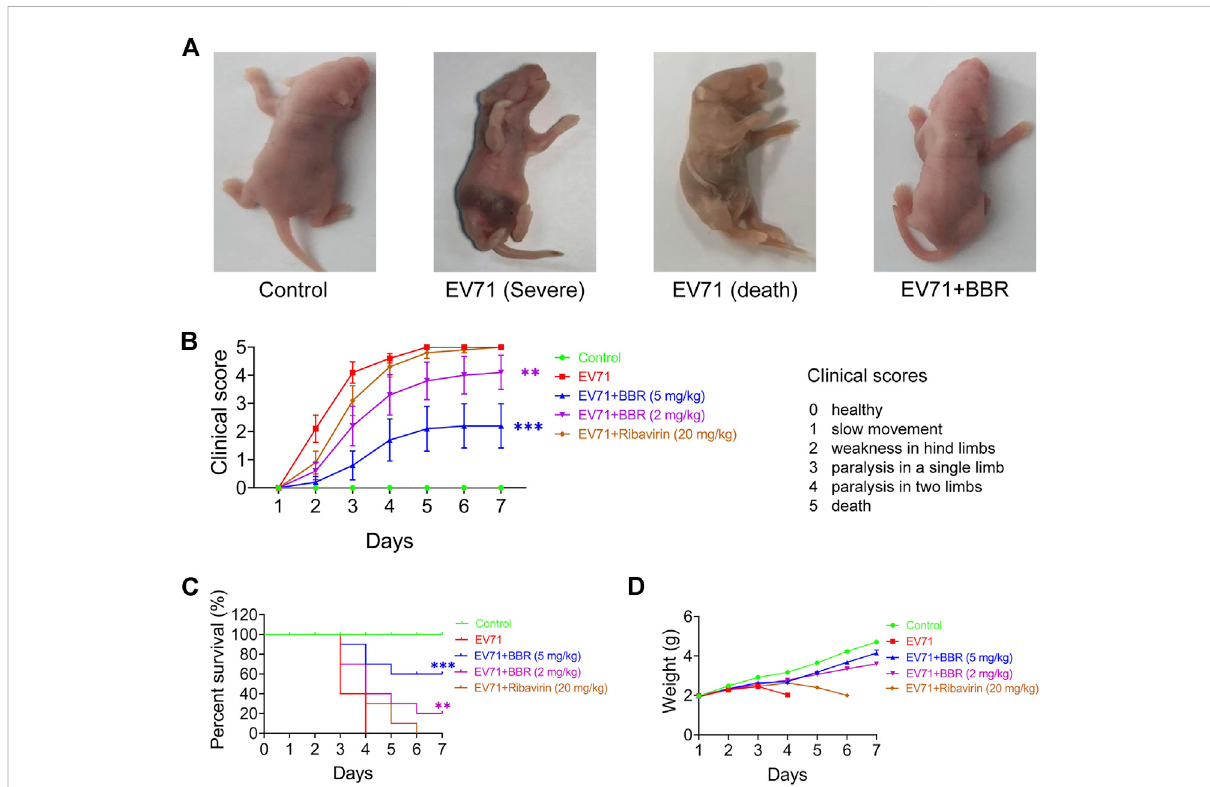
Invivo ef fi cacyofBBRagainstlethalEV71infectioninnewbornmice. (A) Thegeneralconditionofnormal,EV71-infected(SevereandDeath)and BBR treated newborn mice. (B – D) Clincal scores, survival rates and body weight changes of the infected and BBR-treated newborn mice ( n = 10). Data are presented as SD. Statistical signi fi cance was compared between the test groups and the EV71 group was represented by asterisks marked correspondingly in the fi gures, ** p < 0.01, *** p < 0.001 vs. EV71